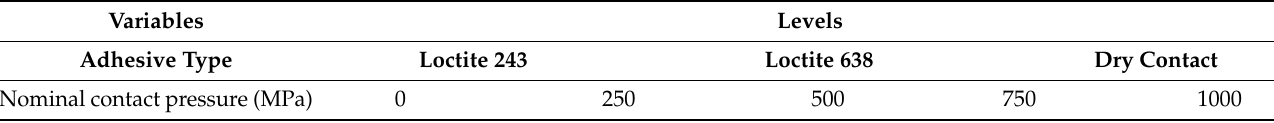
Table 1. Variables of the test plan.